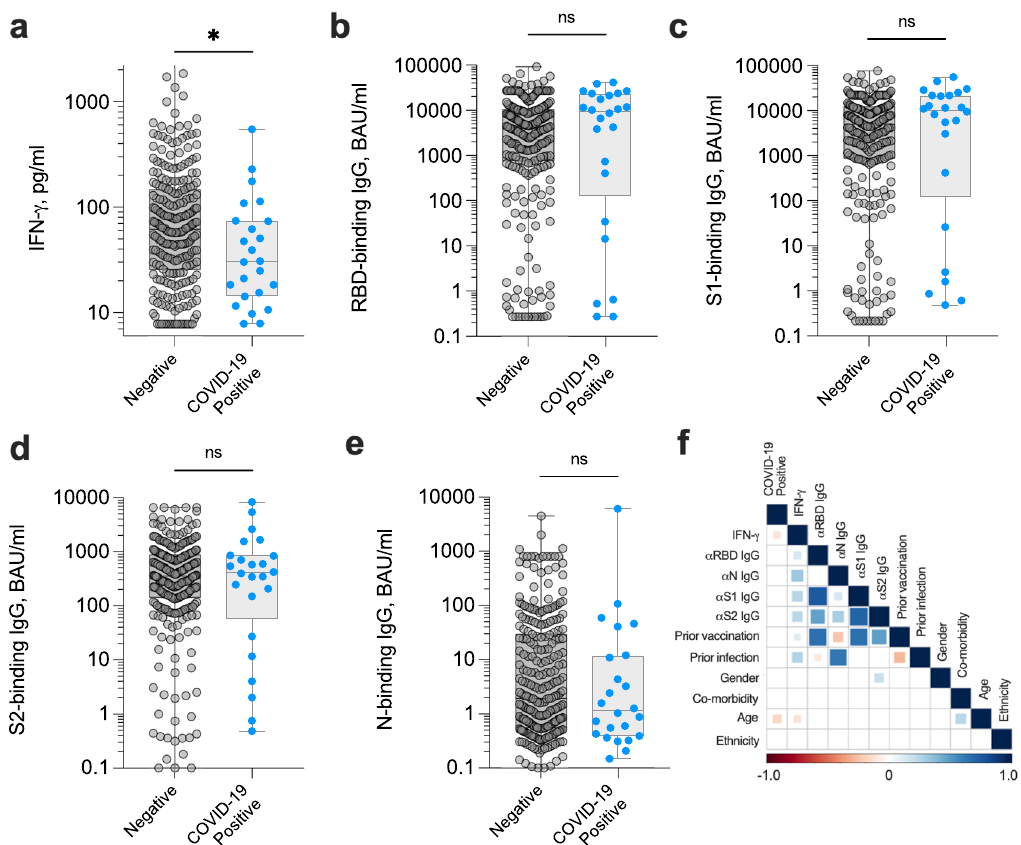
Fig.4|Magnitudeofanti-SARS-CoV-2adaptiveimmuneresponsesmeasuredin capillary blood samples up to 3 months preceding a positive COVID-19 test. Capillary blood samples obtained from study participants ( n =299) were assessed forthemagnitudeofSARS-CoV-2-speci fi cIFN- γ + Tcellresponses( a ;* P =0.034)and SARS-CoV-2-speci fi c IgG-binding responses targeting spike receptor binding domain ( ‘ RBD ’ ) ( b ), spike subunit 1 ( ‘ S1 ’ ) ( c ), spike subunit 2 ( ‘ S2 ’ ) ( d ) and nucleo- capsid ( ‘ N ’ ) ( e ). Participants self-reporting a COVID-19 positive test (PCR and/or lateral fl owtest) arehighlighted; all casesofinfection occurred within3 months of